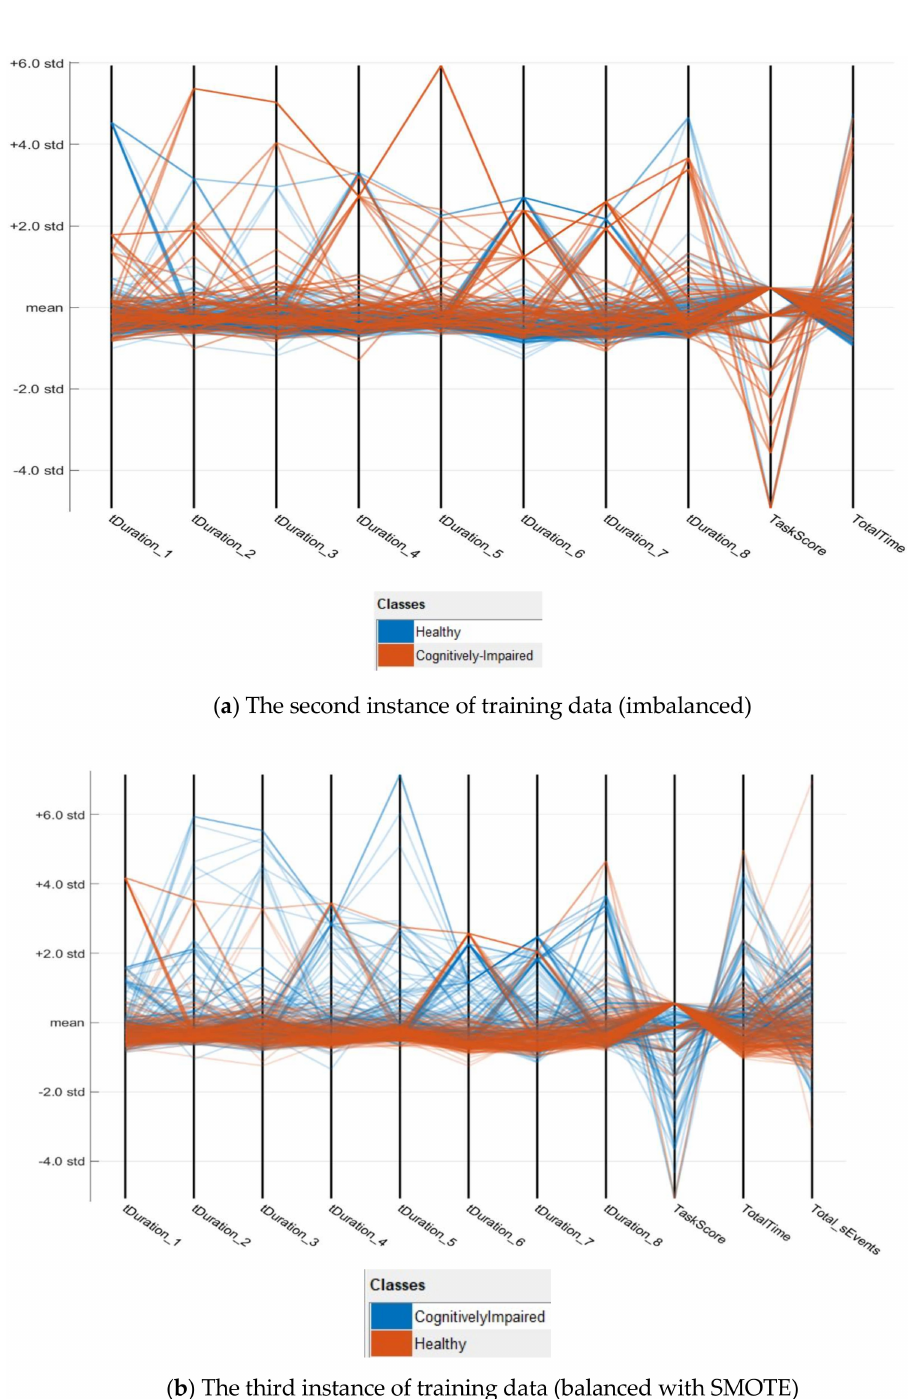
Figure 6. Parallel coordinates plots of cognitively impaired vs. healthy using standard deviation after replacing the missing values. ( a ) The second instance of training data (imbalanced) ( b ) The third instance of training data (balanced with